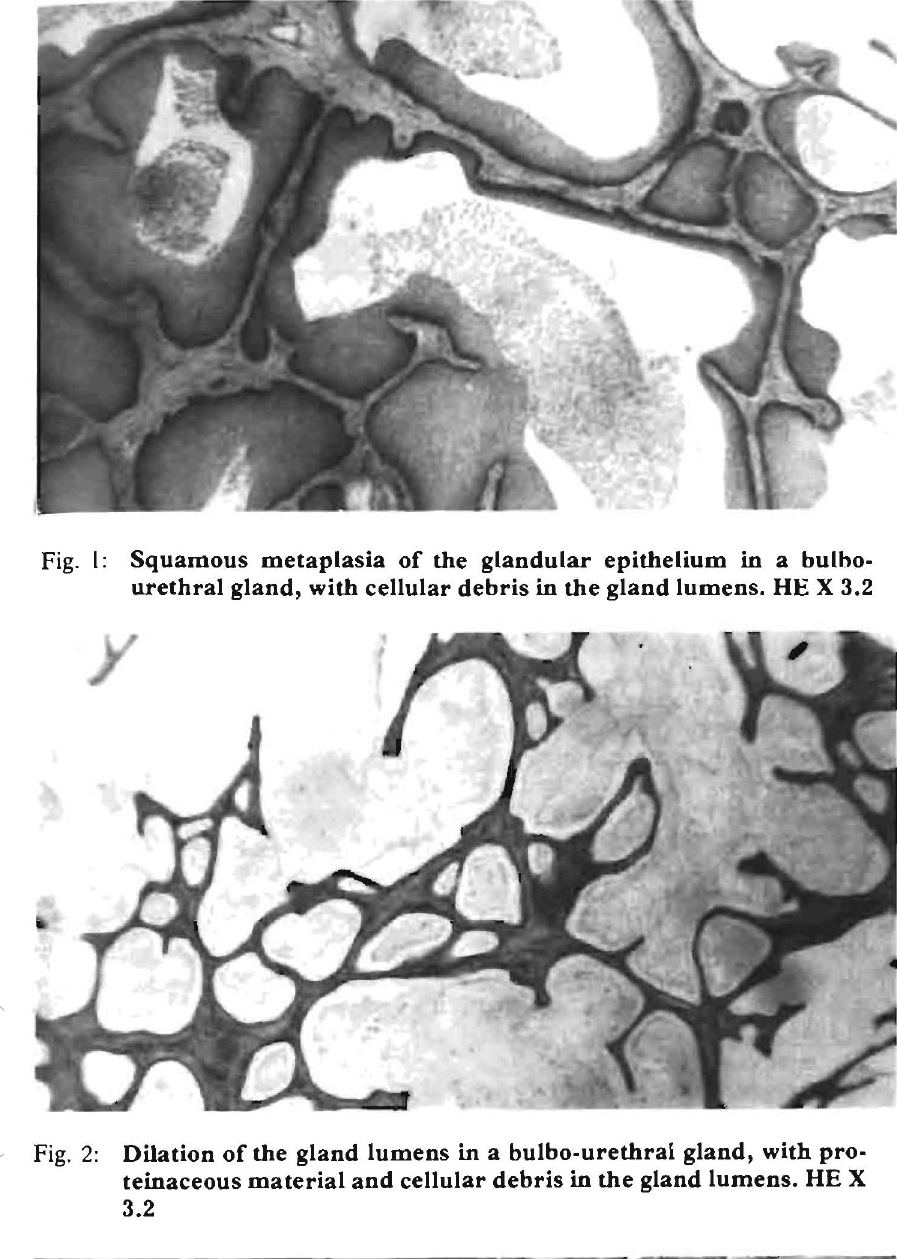
Fig. 2: Dilation of the gland lumens in a bulbo-urethrai gland, with pro teinaceous material and cellular debris in the gland lumens. HE X 3.2